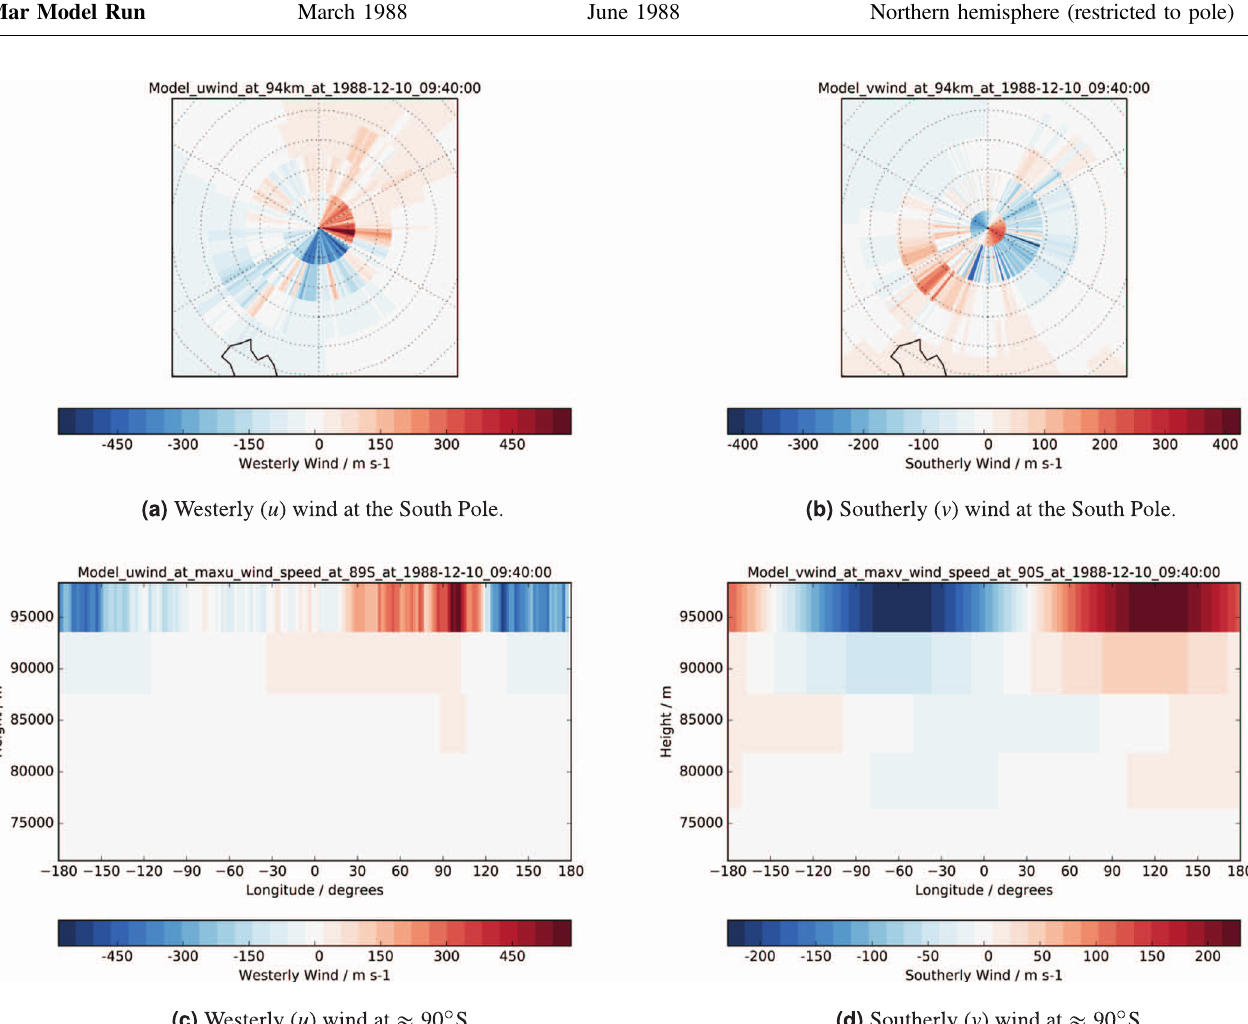
Fig. 5. Modelled wind in the 100 km September model run at the time step before the model crash. Stereographic plots at the uppermost model level (a) and (b). Plots of the wind at the southernmost latitude circle (c) and (d). This makes evident the abnormally high wind speeds causing the model to